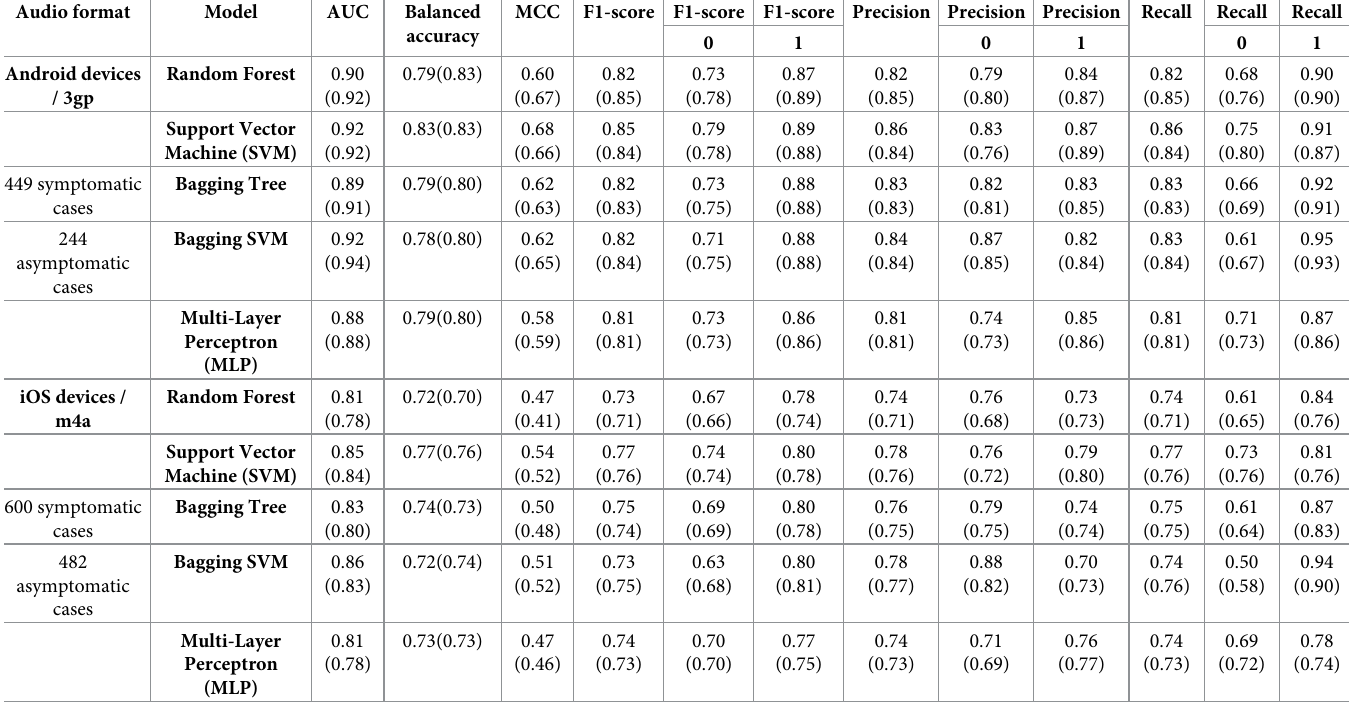
Table 3. Performances of the different